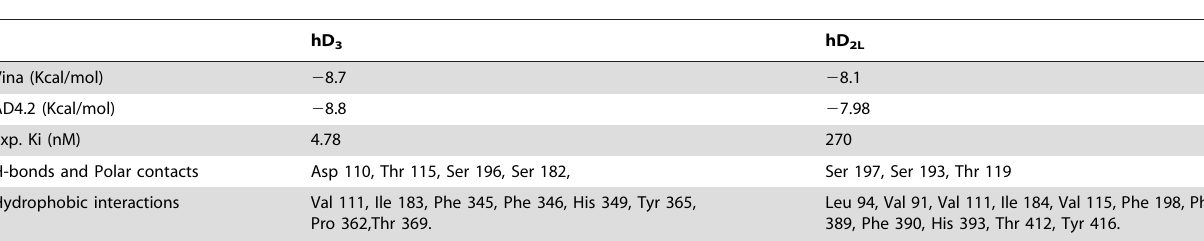
Table 4. Virtual Screening. Top scored compound